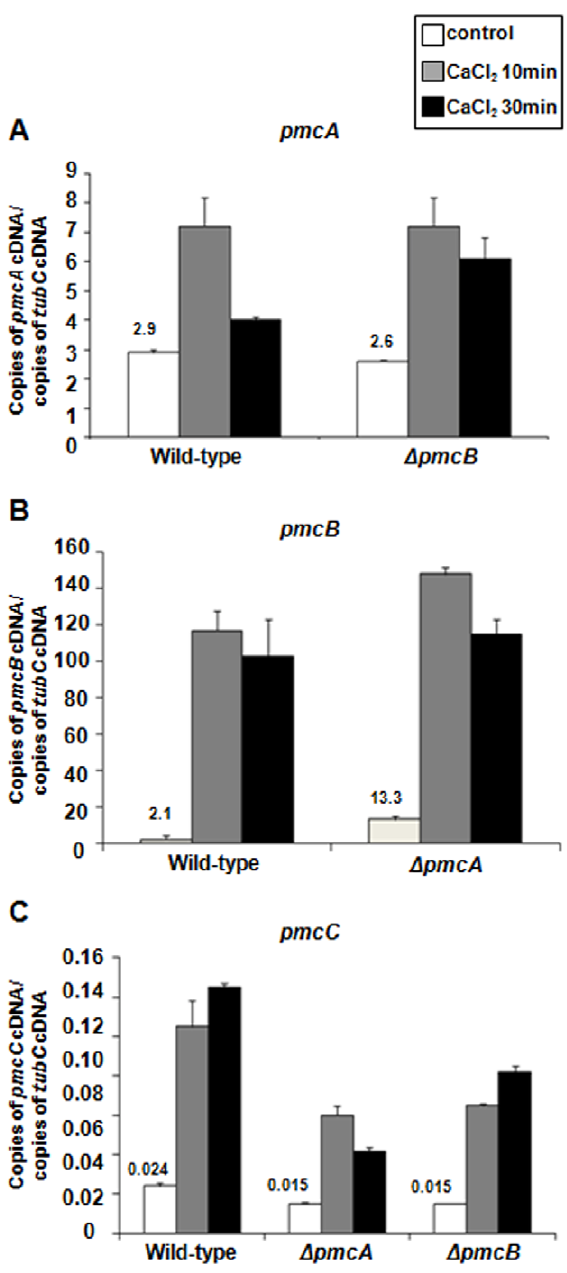
Figure 4. The pmcA-C genes have increased mRNA abundance when exposed to calcium. The absolute quantitation of pmcA , pmcB , and pmcC and tubulin gene expression was determined by a standard curve (i.e., C T –values plotted against a logarithm of the DNA copy number). The results are the means ( 6 standard deviation) of four biological replicates. (A–C) The mRNA abundance of pmcA-C in the wild- type, D pmcA , and D pmcB .